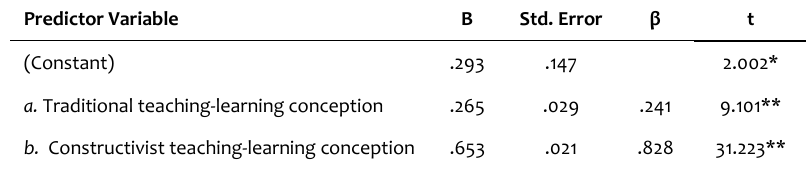
Table 7: Prediction Level of Teachers’ Teaching-Learning Conceptions of the Course Result Activities Competence